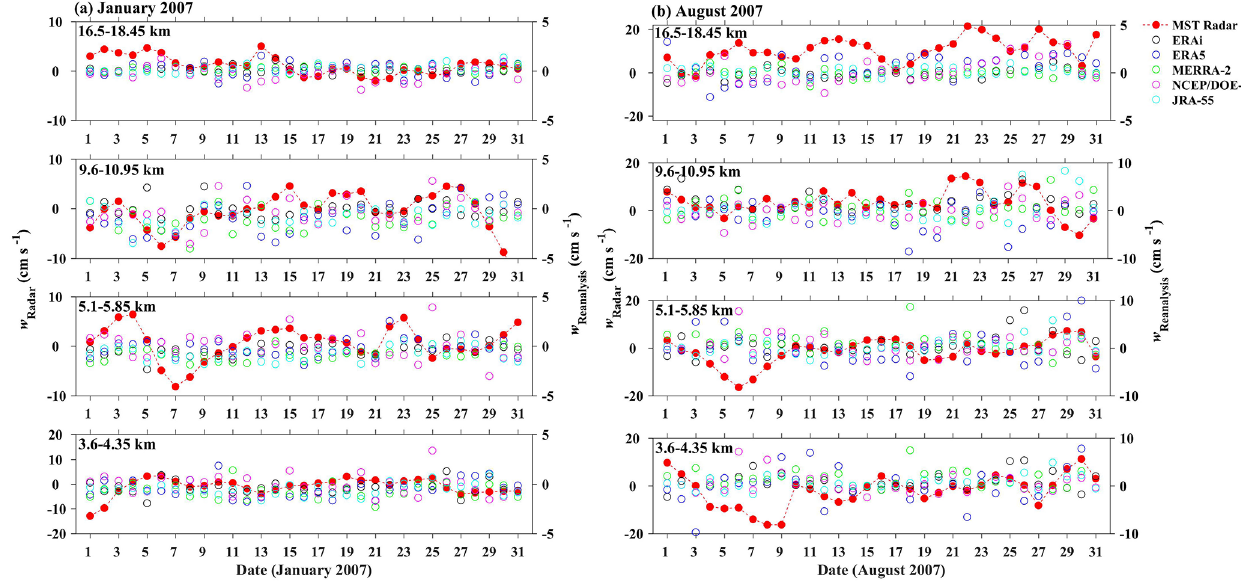
Figure 2. Intercomparison of layer-averaged daily w (12:00UTC) measured from IMSTR with different reanalyses (ERAi, ERA5, MERRA- 2, NCEP–DOE (R-2) and JRA-55) (12:00UTC) over Gadanki for (a) January 2007 and (b) August 2007.